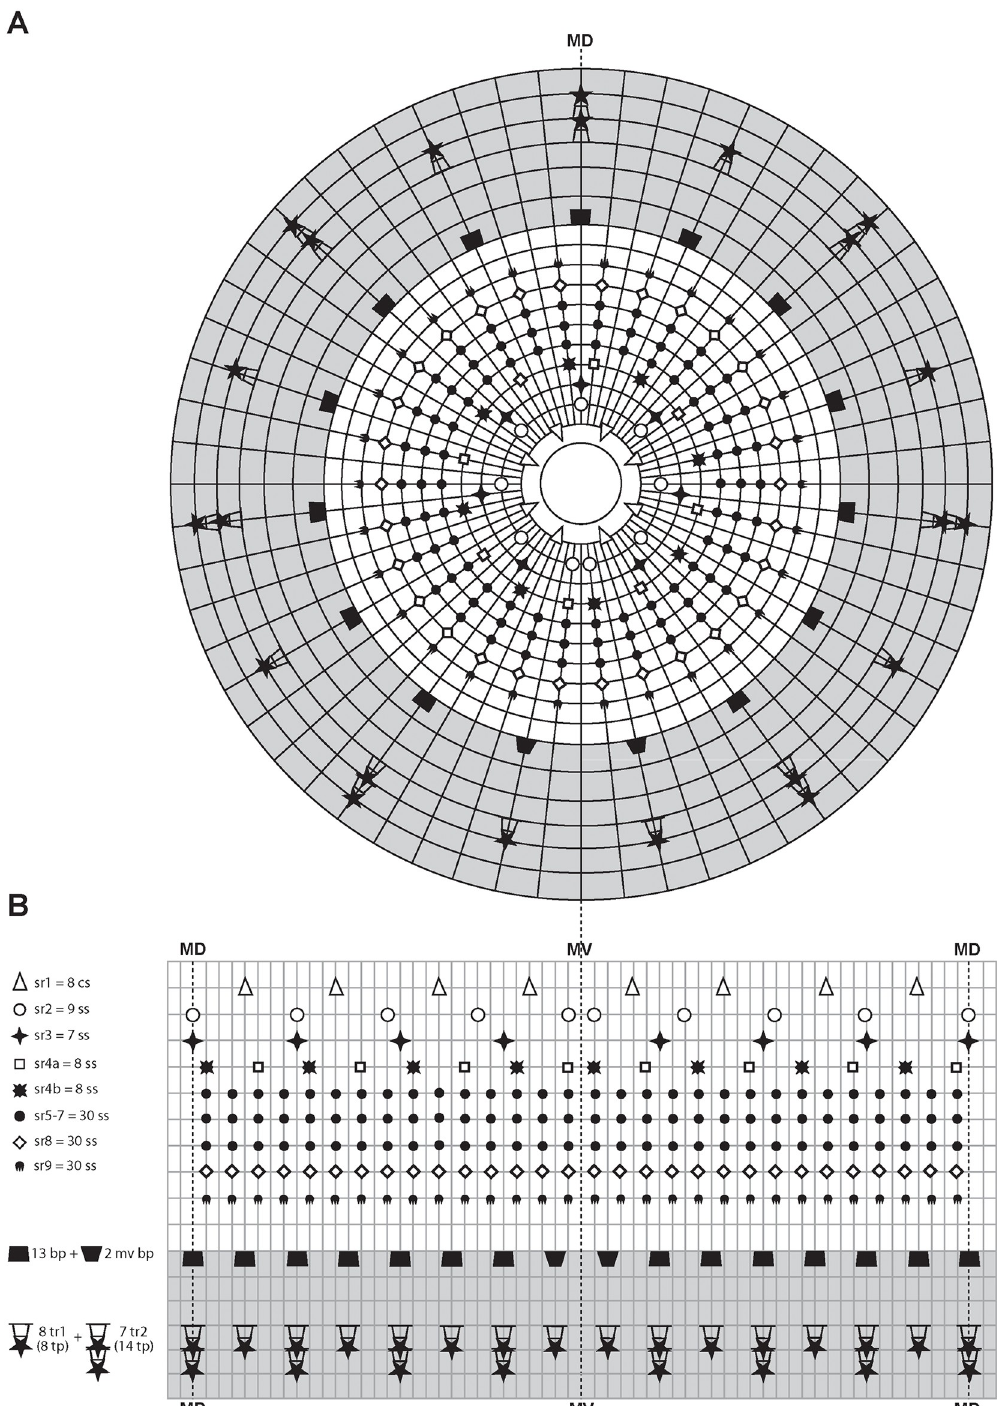
Fig 19. Schematic diagrams of the distribution of introvert and neck appendages in adult forms of Scutiloricus hugoi gen. et sp. nov. Note that for the sake of clarity sexual dimorphism of the clavoscalids is not depicted. The shaded area indicates the neck region. (A) Polar diagram. (B) Planar projection. Abbreviations: bp, basal plate; cs, clavoscalid; MD, middorsal line; MV, midventral line; mv bp, midventral pair of basal plates; sr 1–9 , scalids of 1 st to 9 th row; ss, spinoscalids; tp, trichoscalid plate; tr 1 , single trichoscalid; tr 2 , double trichoscalid.